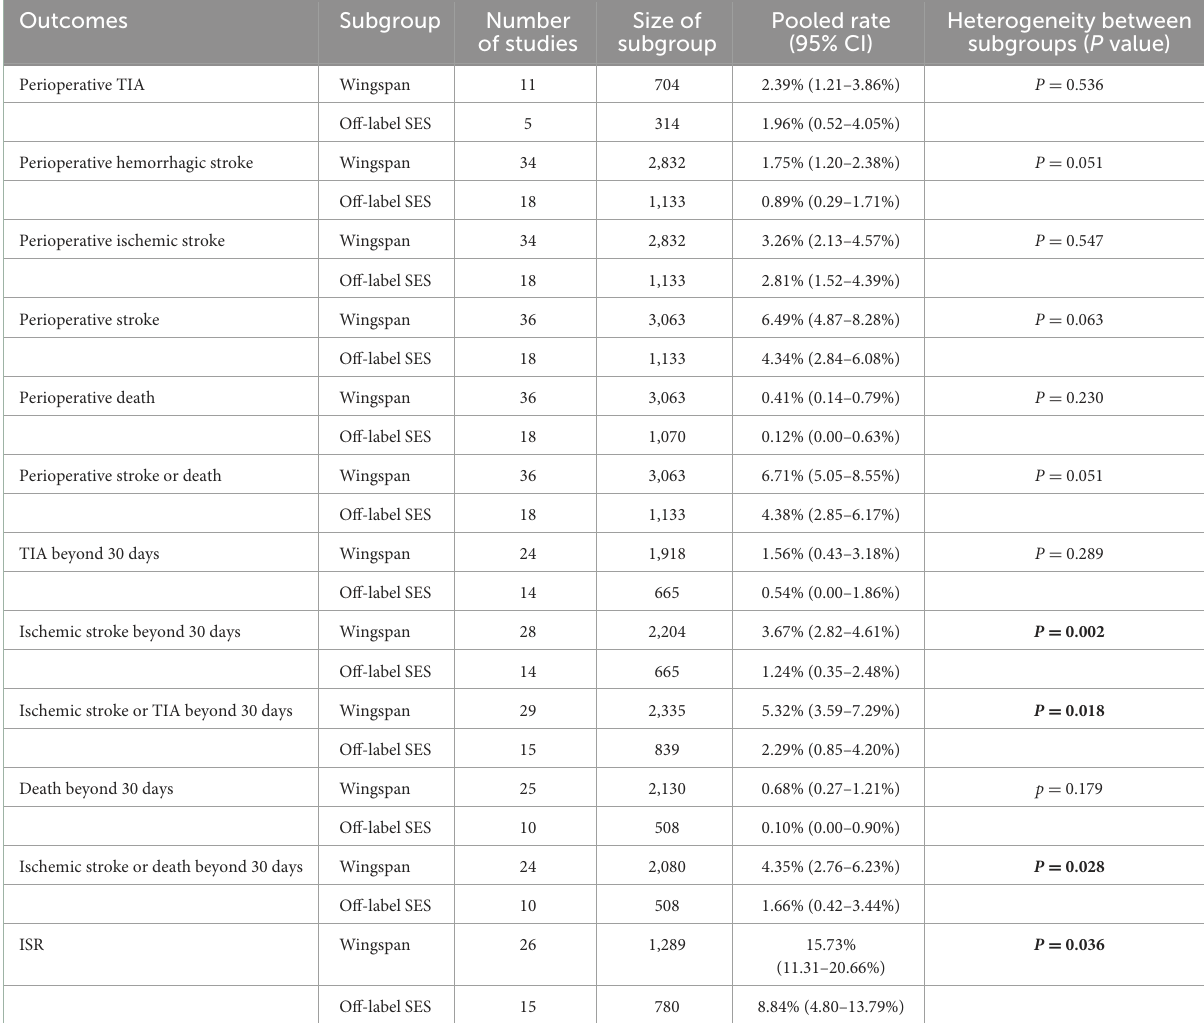
TABLE 4 Summary of subgroup analyses based on stent variety.